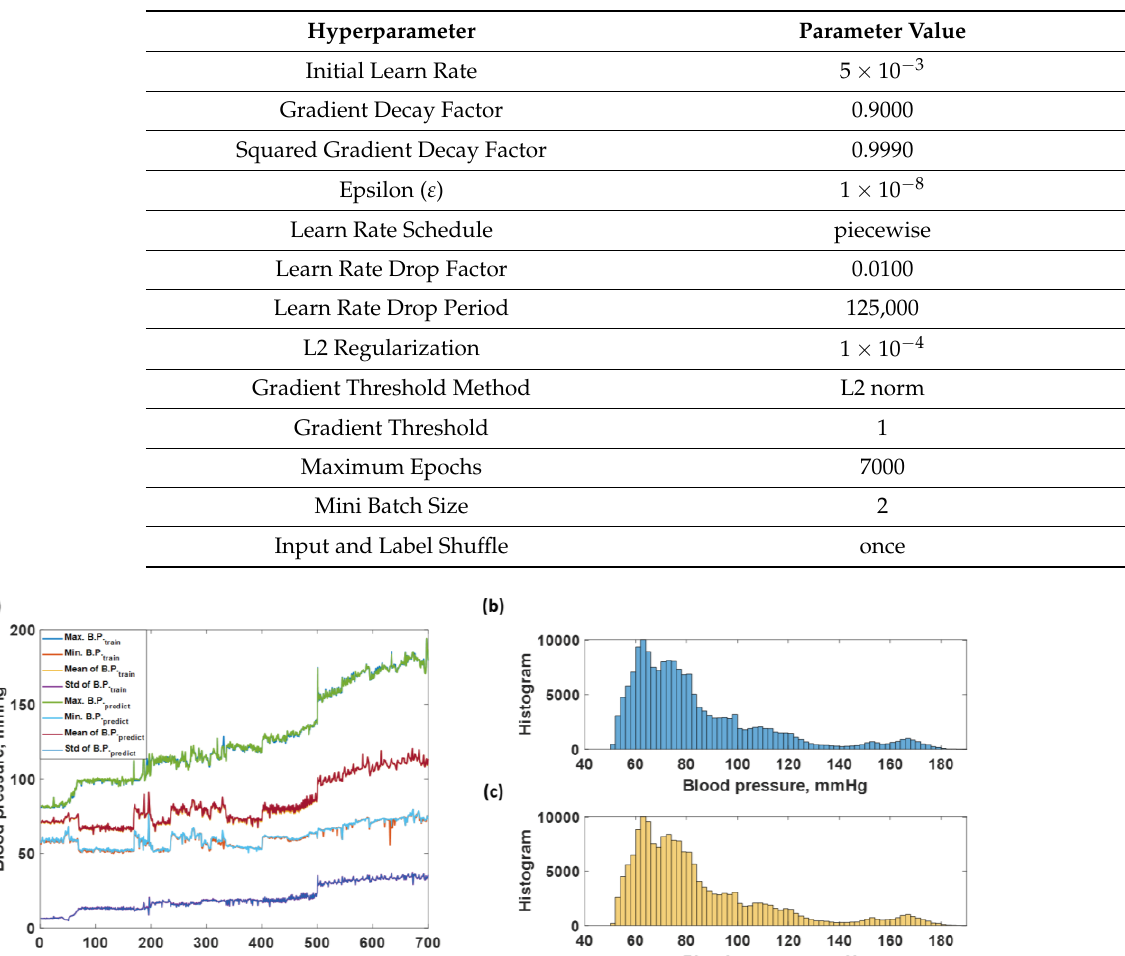
Table 5. Details of the hyperparameters used in the Long Short-Term Memory network.